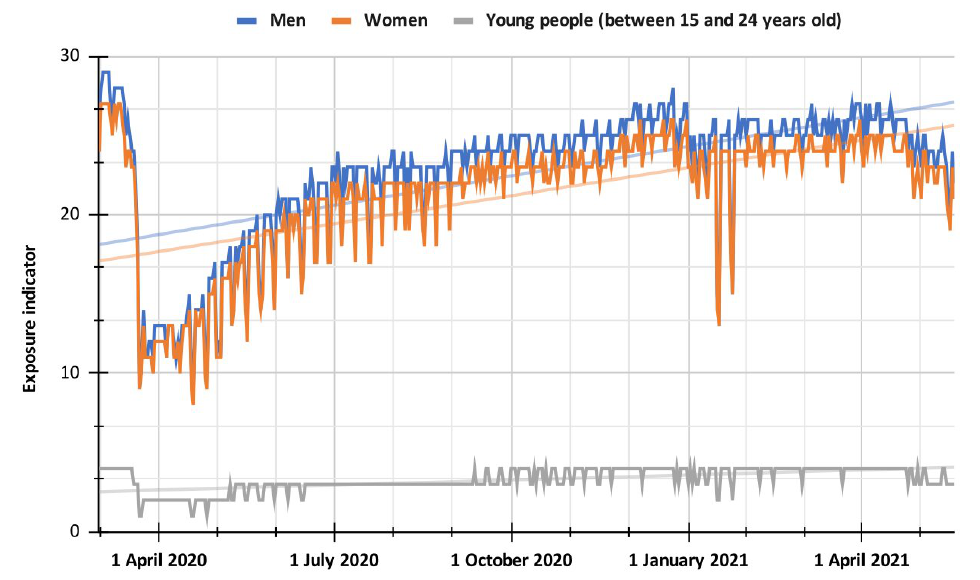
Figure 6. Comparison between the different population groups from 1 March 2020, to 19 May